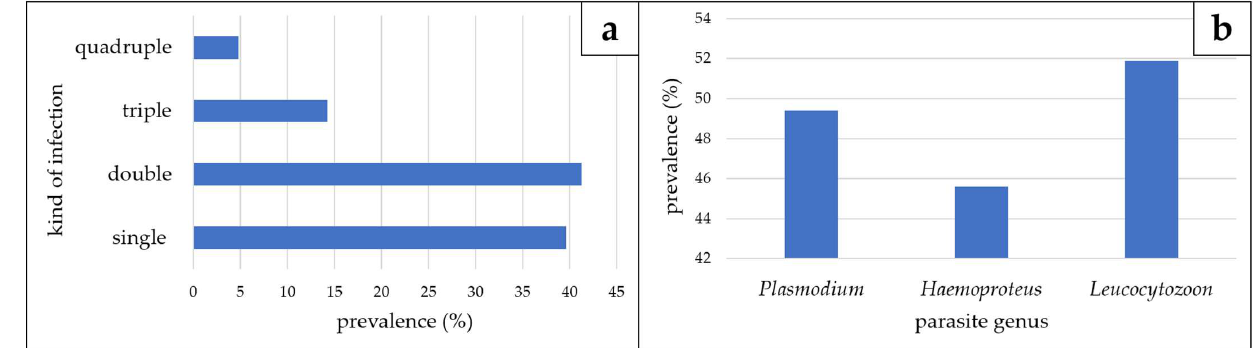
Figure 2. Kind of infection ( a ) and parasite prevalence ( b ) detected in species of the Vangidae examined throughout this study (n = 79).